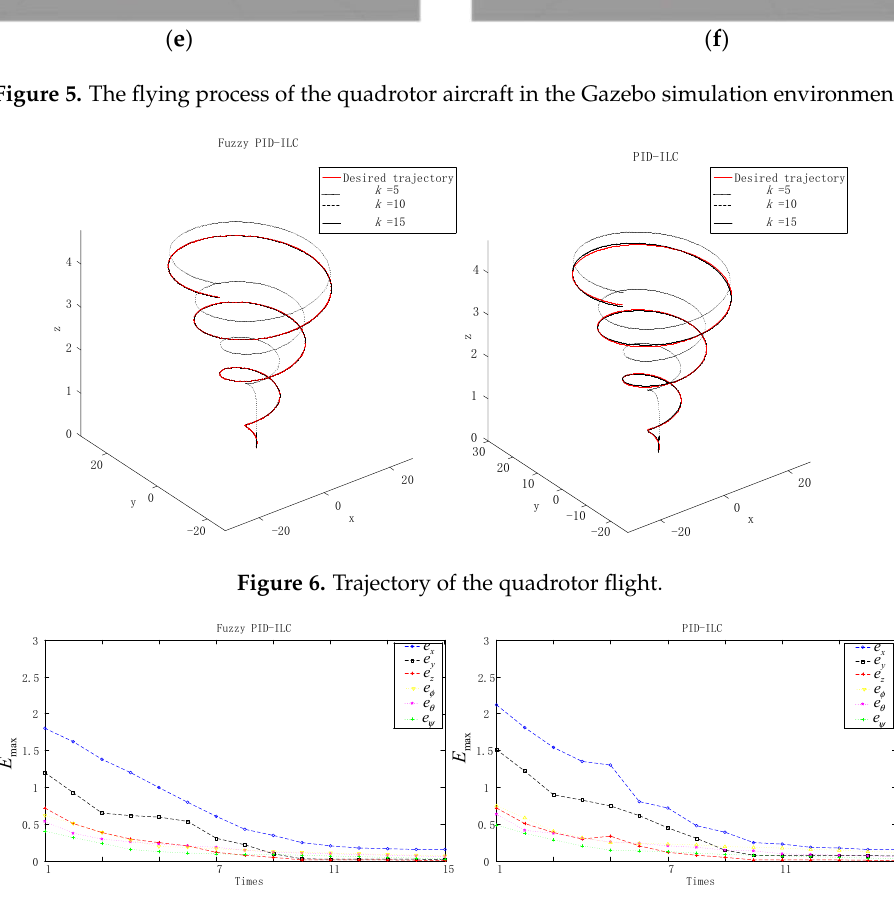
Figure 7. Maximum absolute values of the tracking error.